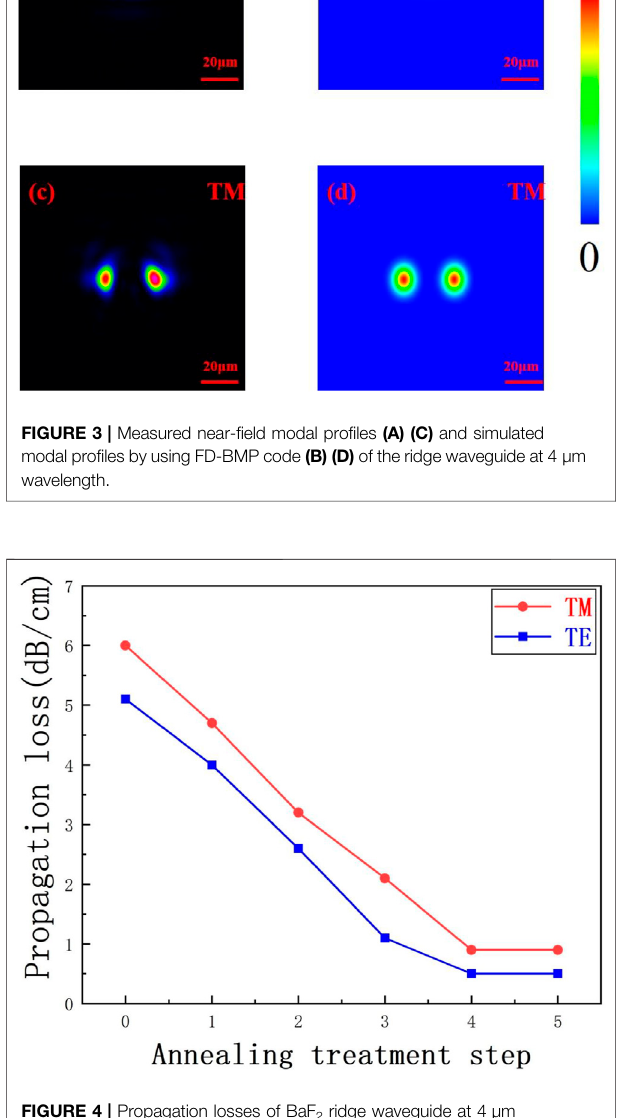
FIGURE 4 | Propagation losses of BaF 2 ridge waveguide at 4 μ m wavelength on TE (blue line) and TM (red line) modes before and after each annealing step (1 –